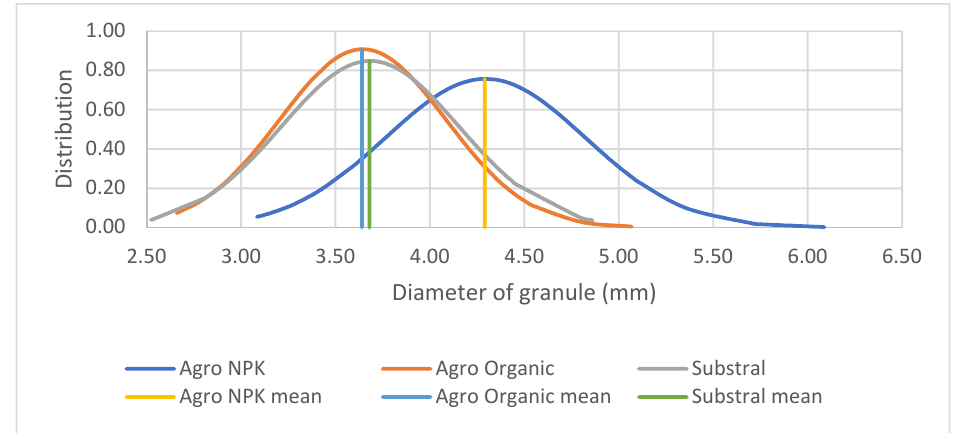
Figure 6. Distribution curves for the mean diameters of fertilizer granules.